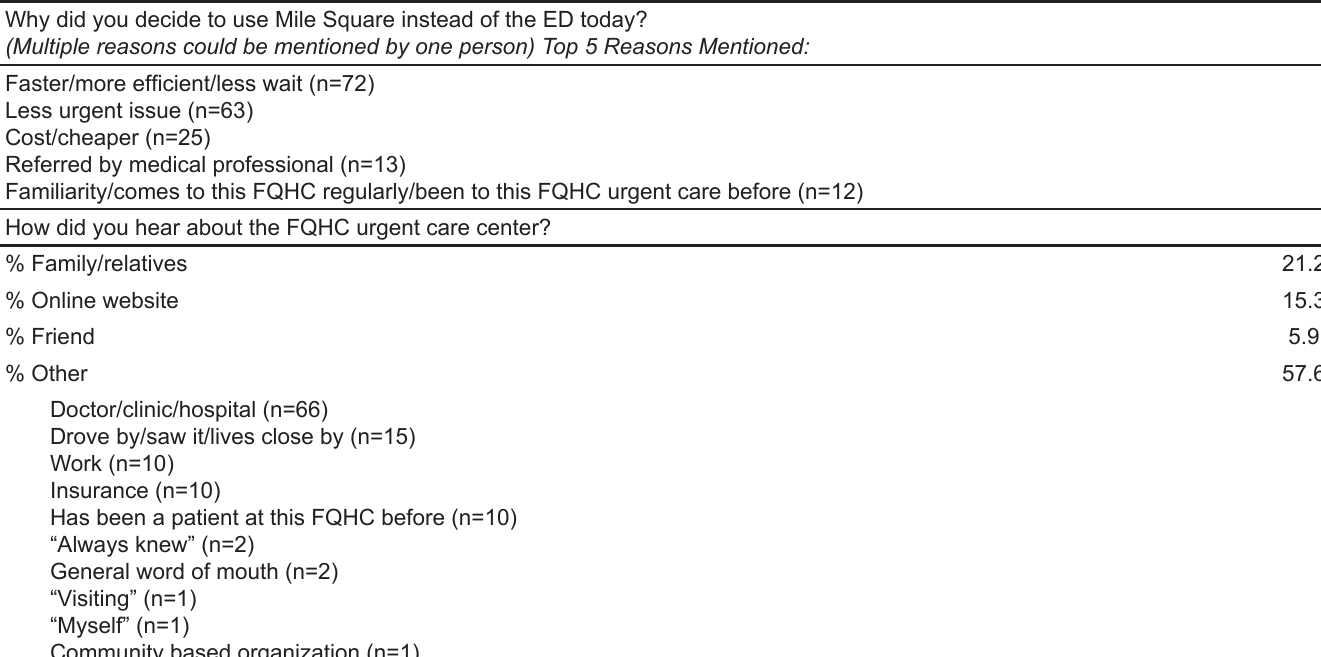
Table 4. Unique questions for federally qualified health center urgent care center patient survey respondents (N =